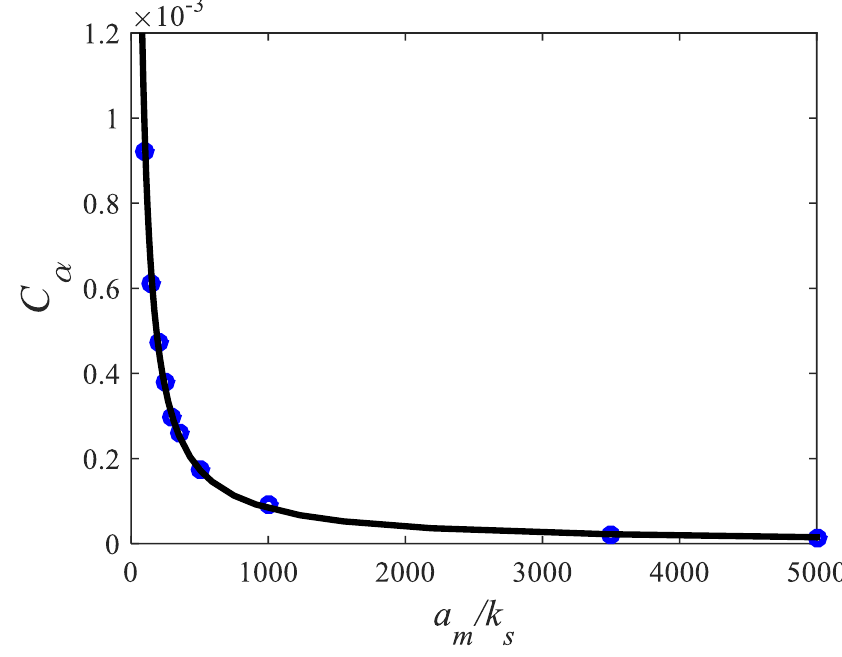
Figure 9. Parameter C α as a function of a m / k s , curve: Equation (12), symbols: data from the BSL k- ω model.